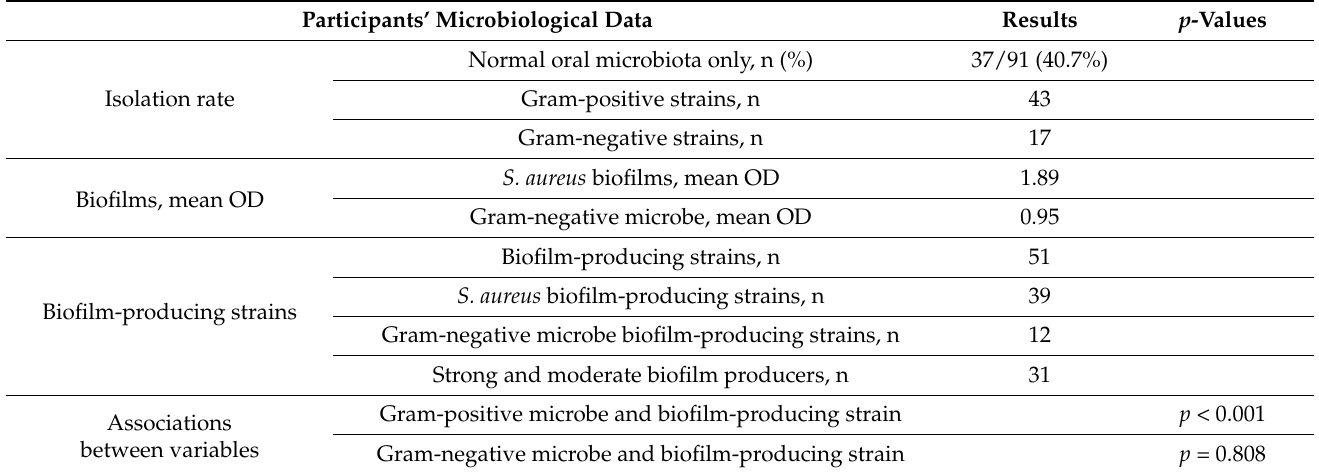
Table 2. Summary of microbiological data of study